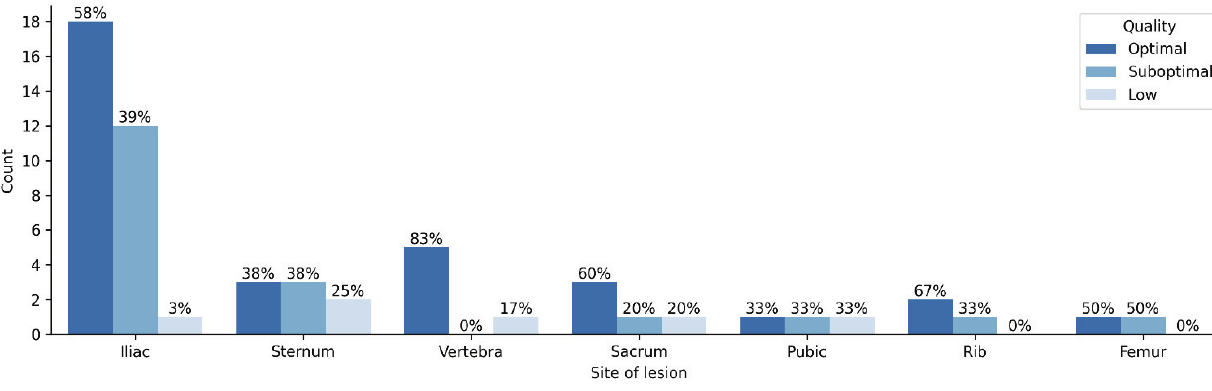
Figure 4. Sample quality and site of lesion.